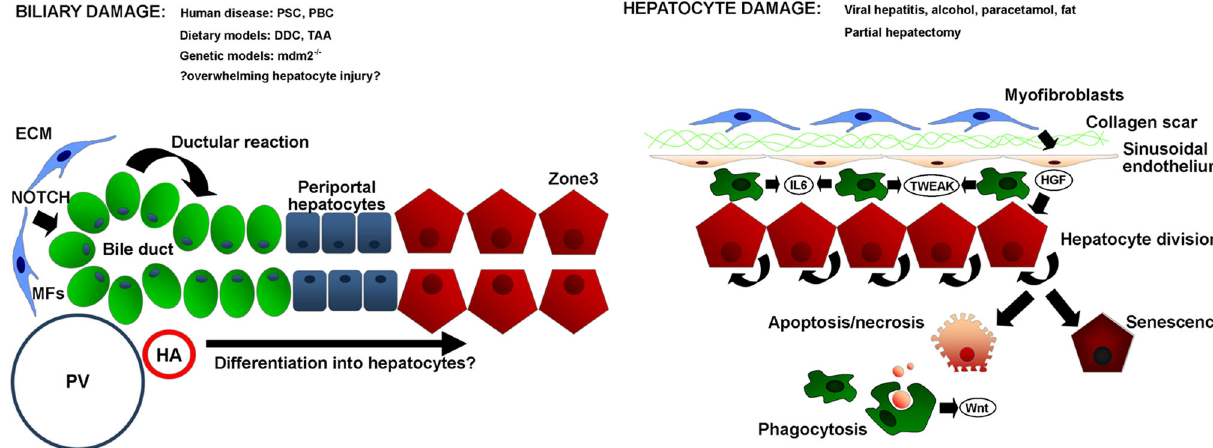
Fig. 1 Mechanisms of parenchymal repair in the adult liver after injury. Schematic micrograph showing the contribution made by hepatocytes vs. hepatic progenitor cells (HPCs) to parenchymal repair under conditions of biliary or hepatocyte damage. In response to biliary injury there is mobilisation and proliferation of hepatic progenitor cells within a laminin rich niche via myo fi broblast-derived signals including Jagged1 to activate the ‘ ductular reaction ’ . In contrast, hepatocyte targeted injuries including partial hepatectomy stimulate hepatocytes to enter mitosis and restore liver mass. In the absence of additional superimposed injury, this capacity is almost in fi nite (up to 90% of liver volume can be resected in rat), but becomes overwhelmed following chronic or fulminant damage when hepatocytes either undergo necrosis or become increasingly senescent. It is thought phagocytosis of hepatocyte debris stimulates the HPC response via signals including macrophage- derived Wnt. PV portal vein, HA hepatic artery, MF myo fi broblast, ECM extracellular